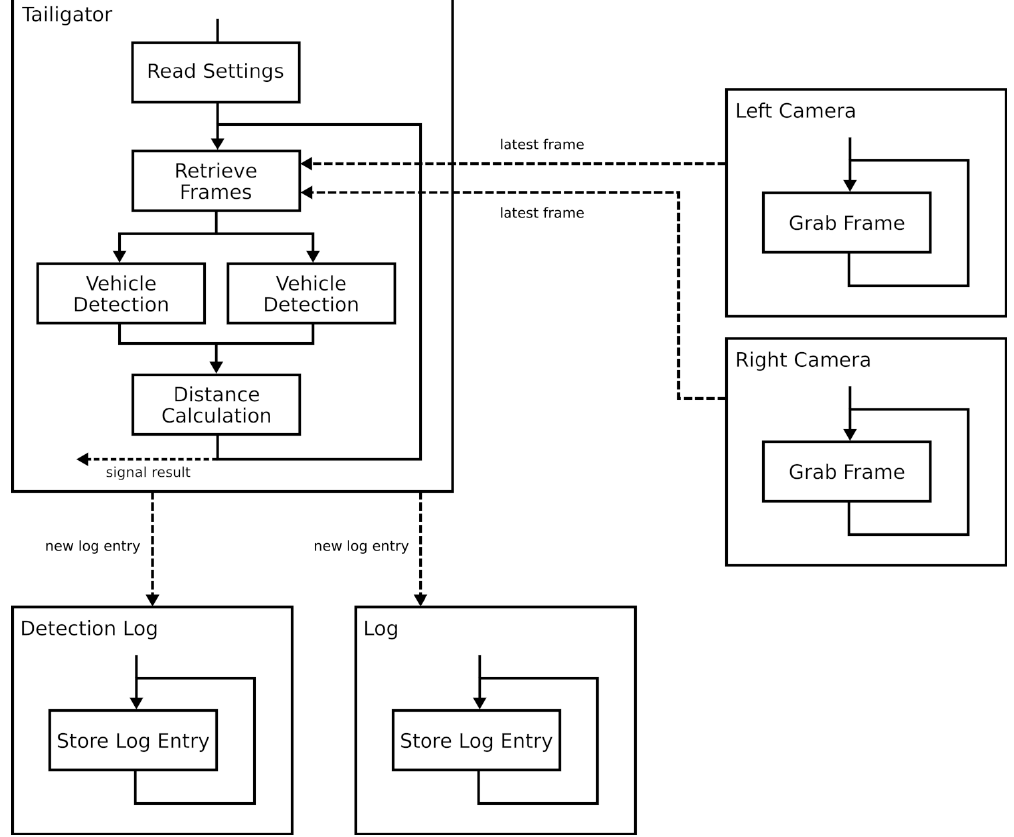
Figure 2. Software architecture of the improved